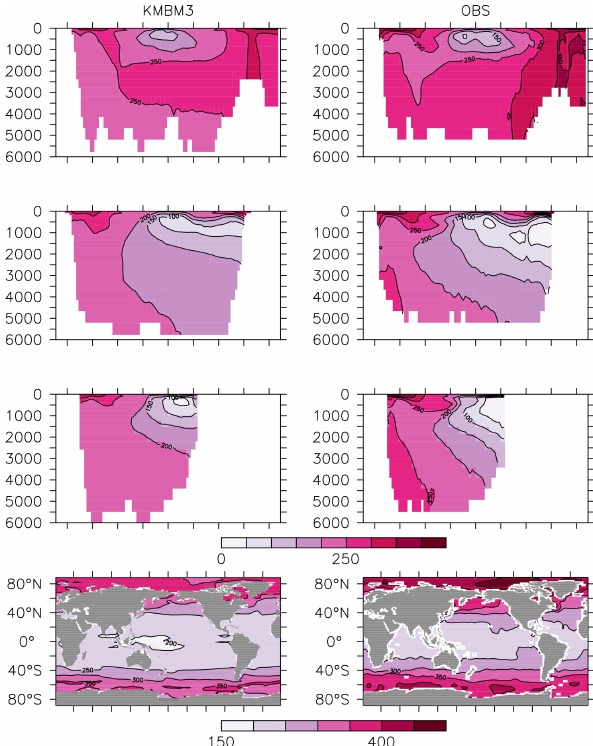
Figure 15. Model (left column) year 2014 Si (mmolm − 3 ) averaged by basin compared to WOA (right column; Garcia et al., 2014b). Regions are as follows: Atlantic (top row), Pacific (second row), Indian (third row) and global surface (bottom